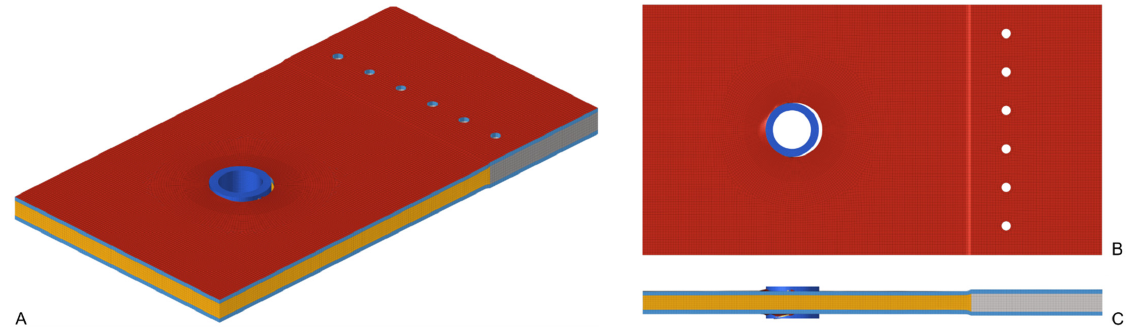
Figure 11. The numerical fracture surface of simple composite joint model. ( A ) Fracture axonometry. ( B , C ) Fracture surface.